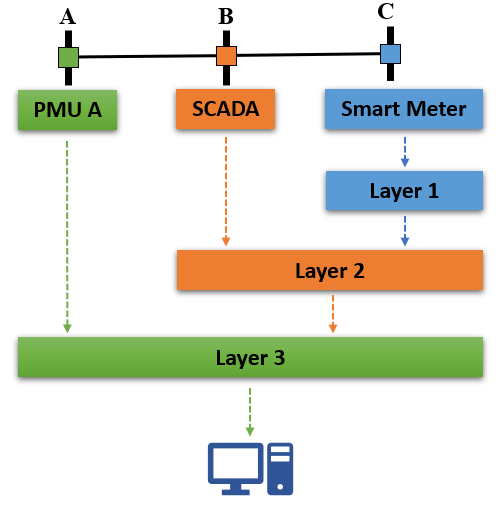
Figure 5. General structure of ISE